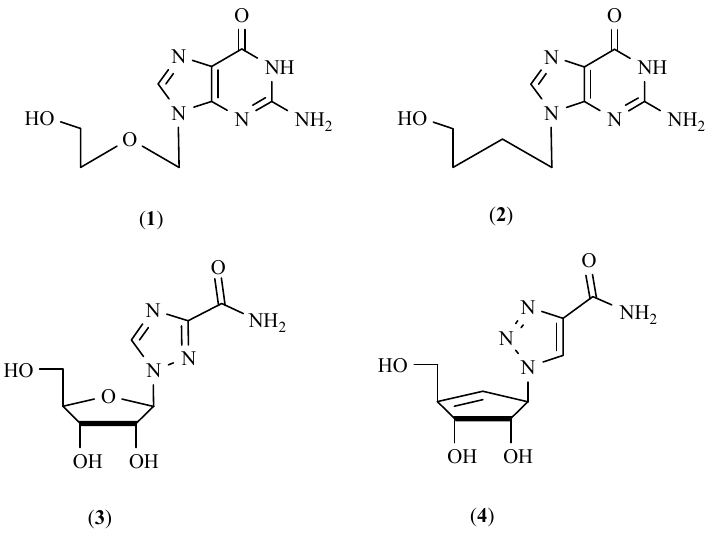
Figure 1. Examples of drugs effective in